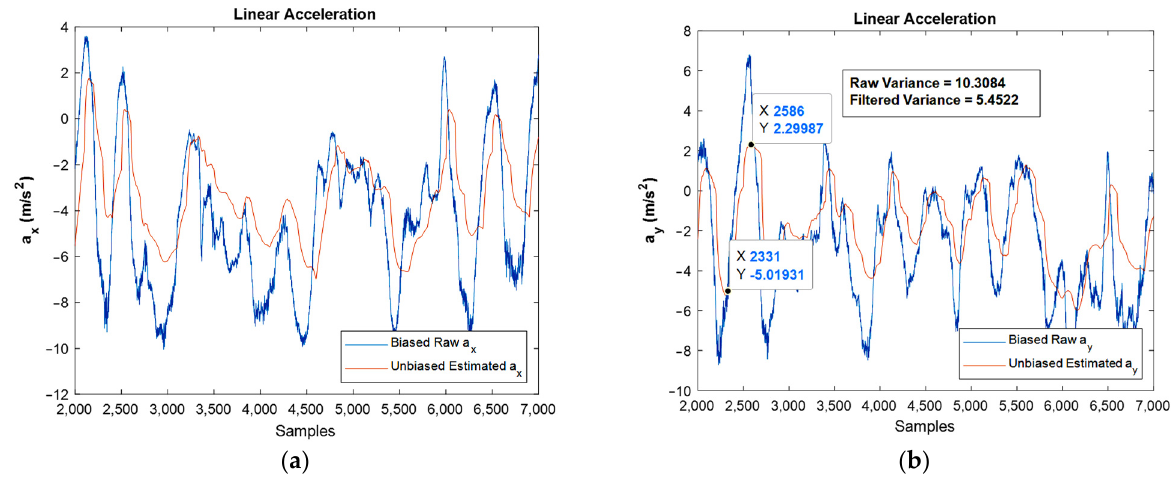
Figure 15. Estimated unbiased linear acceleration of moving IMU in x , and y directions against biased raw ones: ( a , b ), respectively.